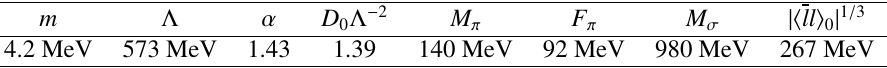
Table 1. Parameters of the model used and resulting physical